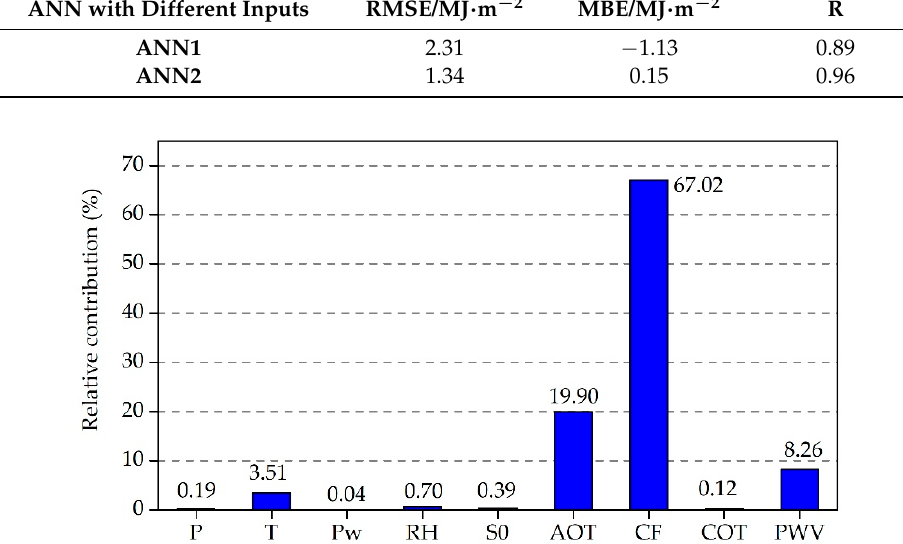
Figure 3. Relative contribution of the parameters.